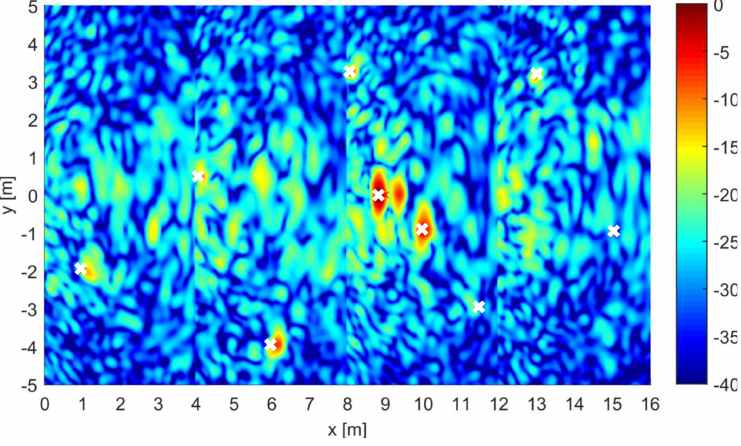
Figure 7. Image as in Figure 5, but obtained by means of the BP algorithm. Table 3. Signal-to-clutter ratio (SCR) for back-projected and matched-filtering (MF)-based tomographic